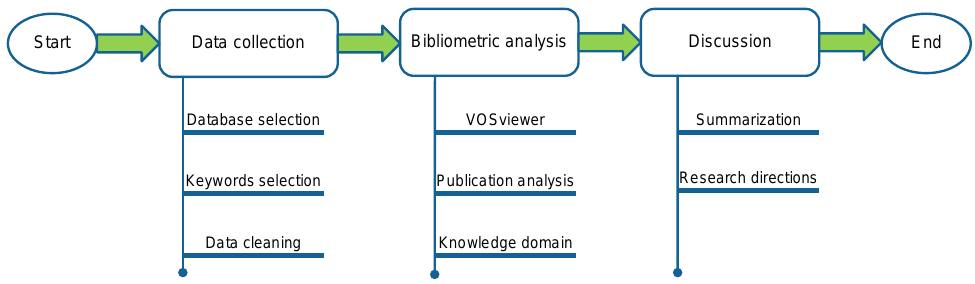
Figure 2. Overview of the methodology.